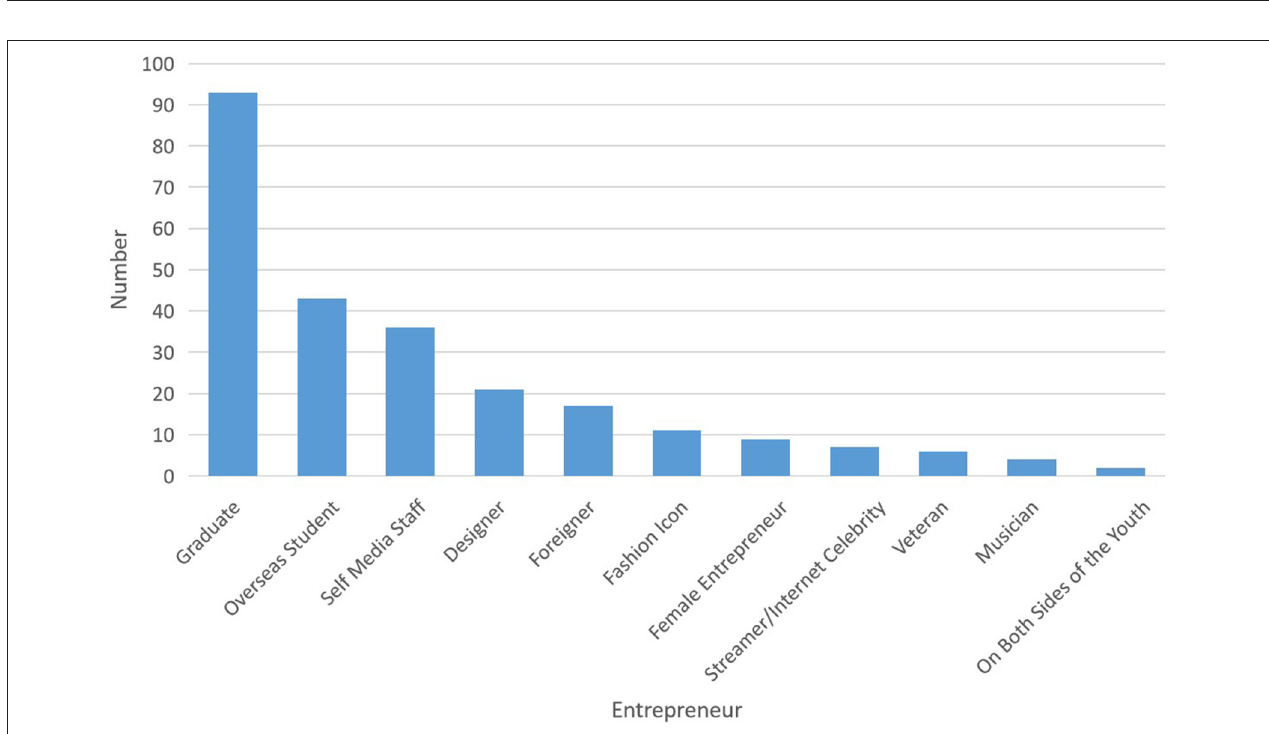
FIGURE 3 | The distribution of associated industries with makerspaces. Plus: indicates that the internet is utilized in the various industries.